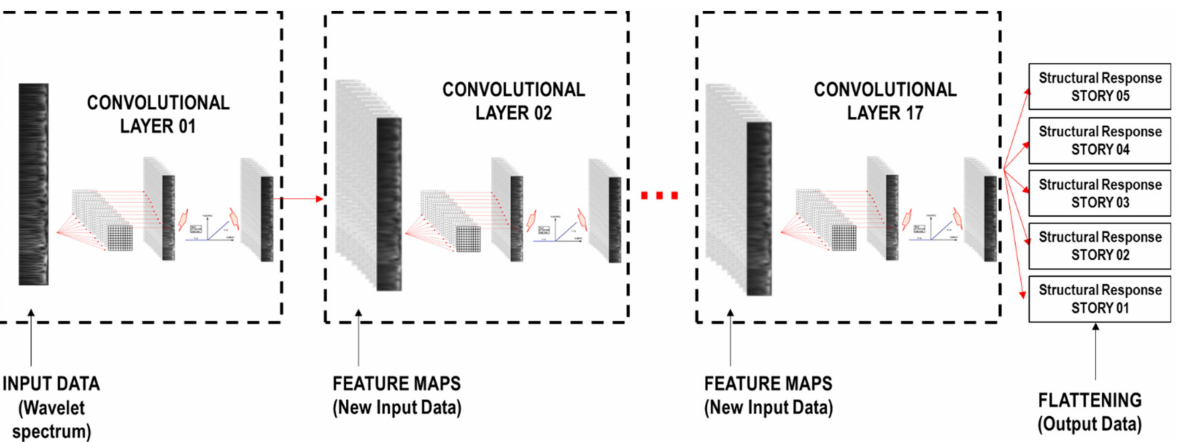
Figure 14. Convolutional neural network scheme. Structural response: ductility ratio, story drift ratio, or